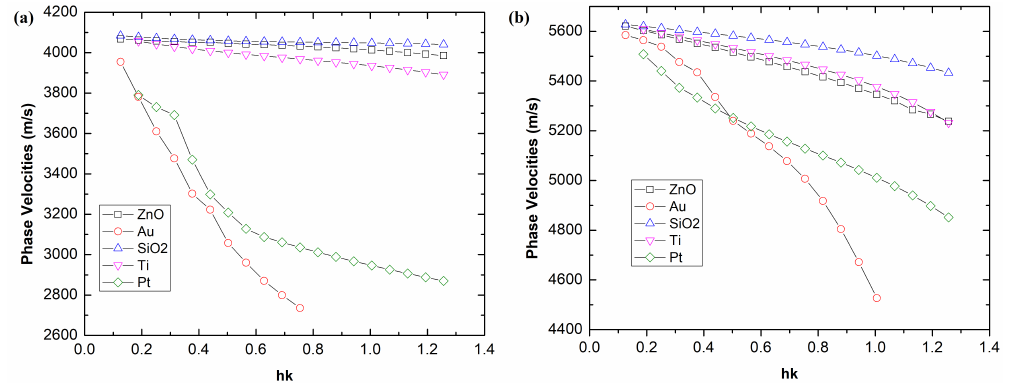
Figure 4. Phase velocities of ( a ) Rayleigh’s mode and ( b ) Sezawa’s mode versus normalized